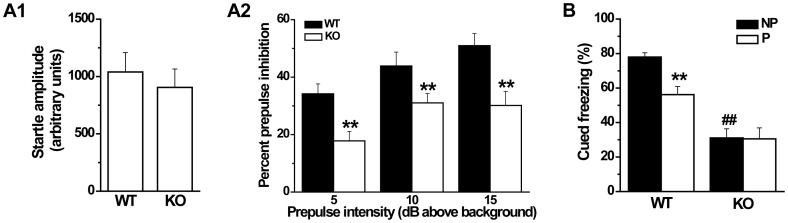
GAT1 KO mice show impaired prepulse inhibition and latent inhibition.
A1, Startle amplitude to a 120 dB acoustic stimulus was normal in GAT1 KO mice. A2, GAT1 KO mice exhibited significantly reduced percent prepulse inhibition of the acoustic startle response across prepulse intensities (70, 75, 80 dB). n = 9–10 for each genotype, ** p<0.01 vs WT, ANOVA. B, In cued fearing test, GAT1 KO mice showed reduced percent freezing. Pre-exposure to cue without shock significantly impaired the formation of fear memory in WT mice but not in GAT1 KO mice. n = 9–10 for each group, ##
p<0.01 vs WT, ** p<0.01vs NP, ANOVA.